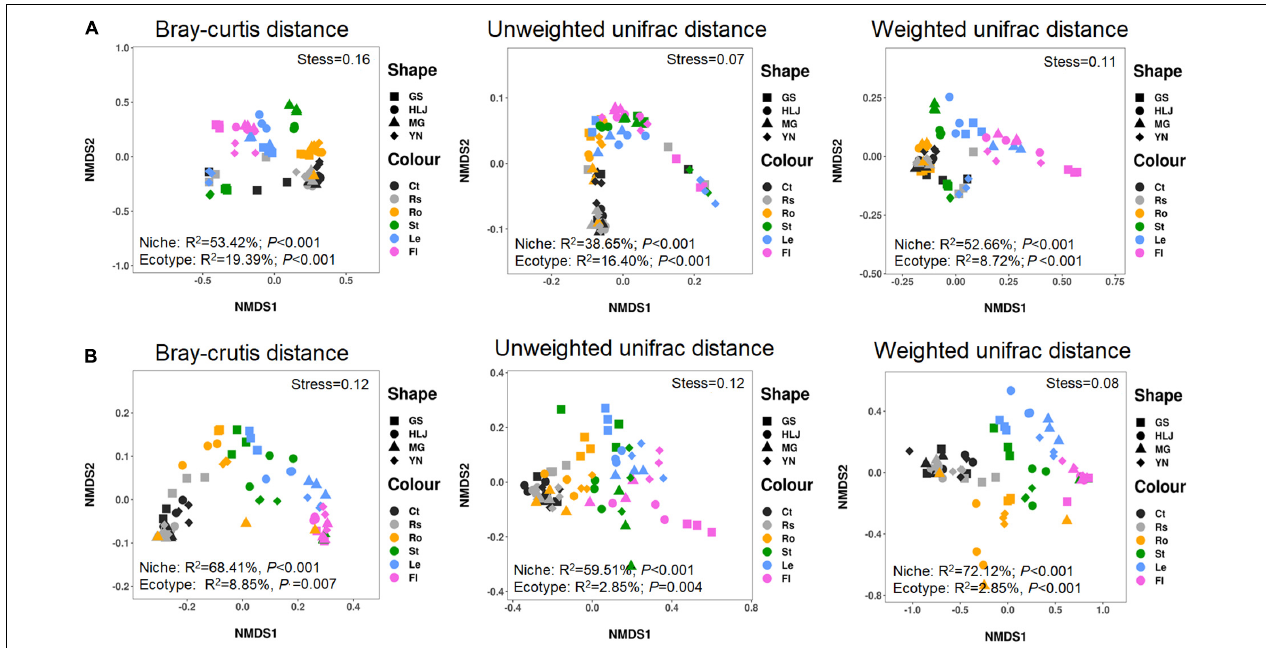
FIGURE 1 | Non-metric multidimensional scaling (NMDS) ordinations of microbial communities associated with hemp plants. (A) Bacteria. (B) Fungi. GS, HLJ, MG, and YN represent Gansuqingshui, Huoma No. 1, Yunmaza No. 1, and Yunnan No. 1, respectively. Ct, Rs, Ro, St, Le, and Fl represent bulk soil, rhizosphere soil, root endosphere, stem endosphere, leaf endosphere, and flower endosphere,